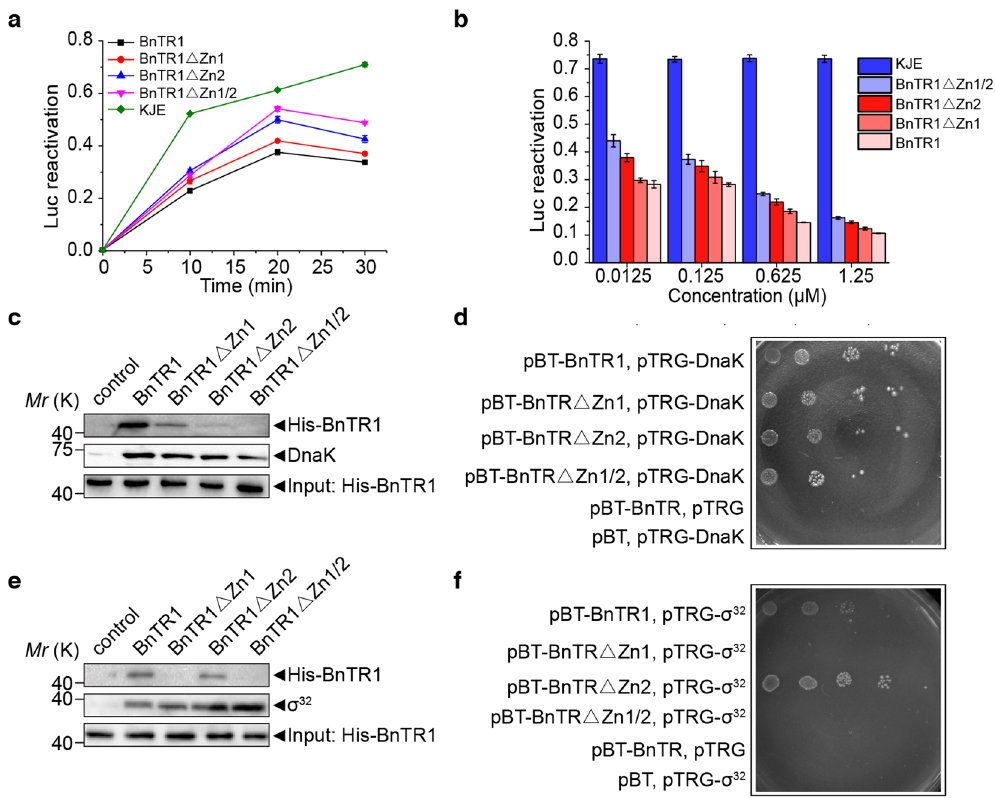
Figure 4. BnTR1 interacts with DnaK and σ 32 in vivo . ( a ) Refolding denatured luciferase by the KJE chaperone team with or without BnTR1 or BnTR1 mutants (0.0625 μ M). ( b ) The same reactivation system as described in ( a ) was used with a series of BnTR1 or BnTR1 mutant concentrations incubated for 30 min. ( c ) and ( e ) Co- immunoprecipitation of BnTR1 with DnaK ( c ) and σ 32 ( e ). Purified BnTR1 and mutant forms were incubated with DnaK or His- σ 32 . The control group did not contain DnaK or His- σ 32 , and the input lane was used to adjust the concentration of BnTR1 and mutant forms in the reaction system. ( d ) and ( f ) Interaction analysis of BnTR1 and DnaK ( d ) or σ 32 ( f ) in the bacterial two-hybrid system. The data are presented as means ± s.d. of three independent experiments ( a , b ). Full-length blots are presented in Supplementary Figure